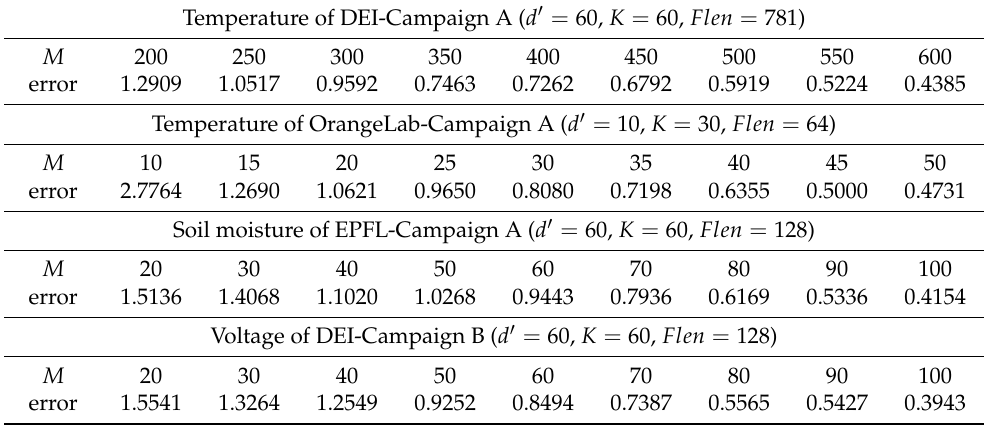
Table 4. Reconstruction errors of four different datasets vs. measurement M for